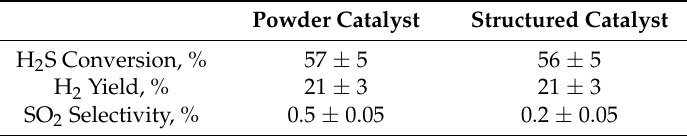
Table 2. Catalytic performances of the powder and structured catalyst.